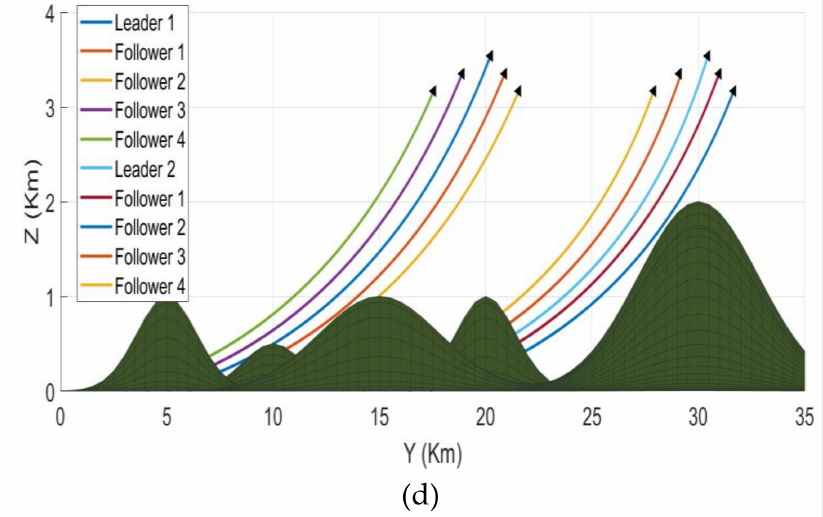
Figure 8. The first mission scenario containing two clusters with five UAVs each reaching a leader- follower formation; ( a ) shows the 3D version while ( b – d ) represent the XZ , XY , and YZ axis versions, respectively. The legend is the same for all simulations.